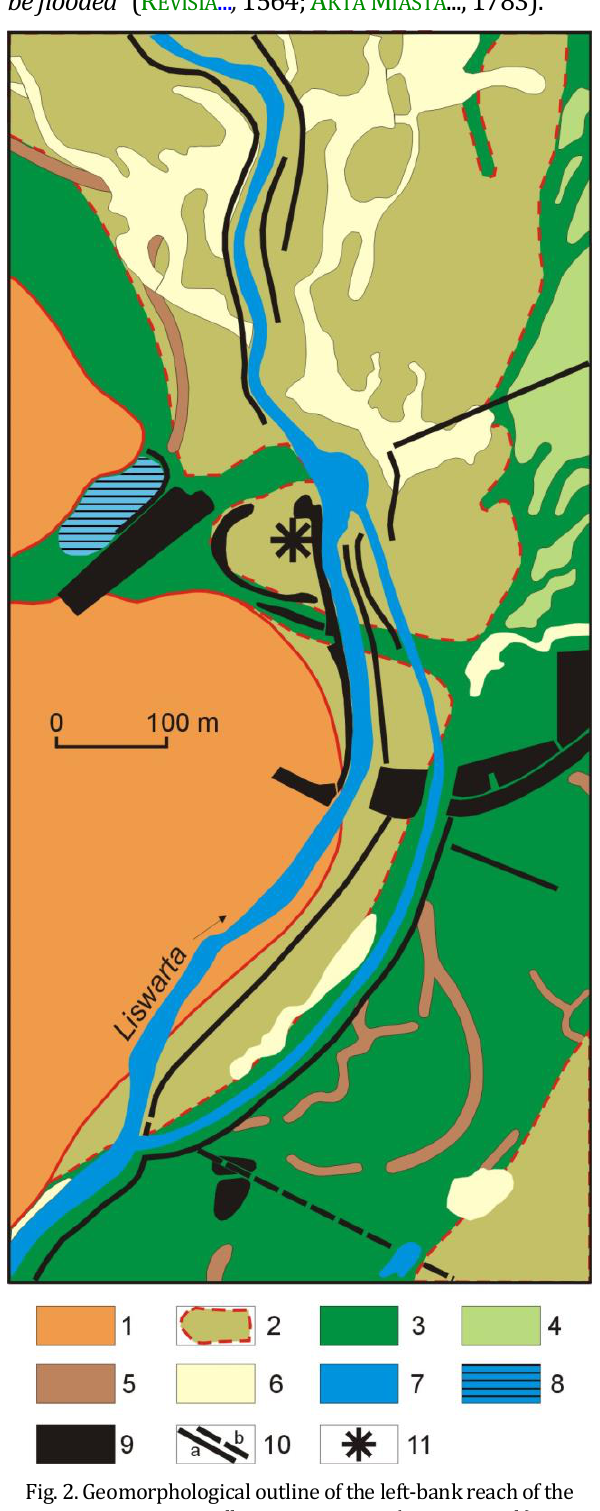
Fig. 2. Geomorphological outline of the left-bank reach of the River Liswarta valley near Krzepice (own research) 1 – plateau, valley floor; 2 – splay and terrace level (late Pleistocene-Holocene); 3 – flood plain; 4 – older bars formed during floods and interchannel islands; 5 – palaeochannels; 6 – younger landforms created by floods (crevasse splays and sand shadows); 7 – flowing and stagnant waters; 8 – pond filled with water in the first half of the 19 th century; 9 – embankments and artificial terraces; 10 – dykes and levees (a – existing; b – dismantled, marked on old maps); 11 – Marcelin watermill